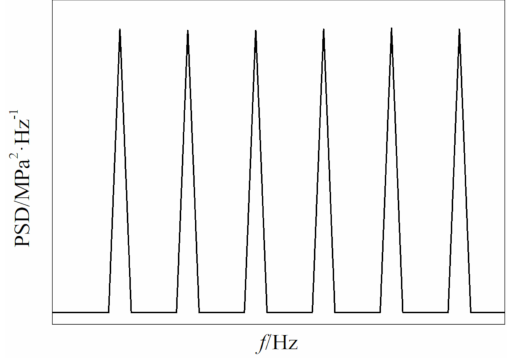
Figure 3. Multiple peak simulation spectrum.